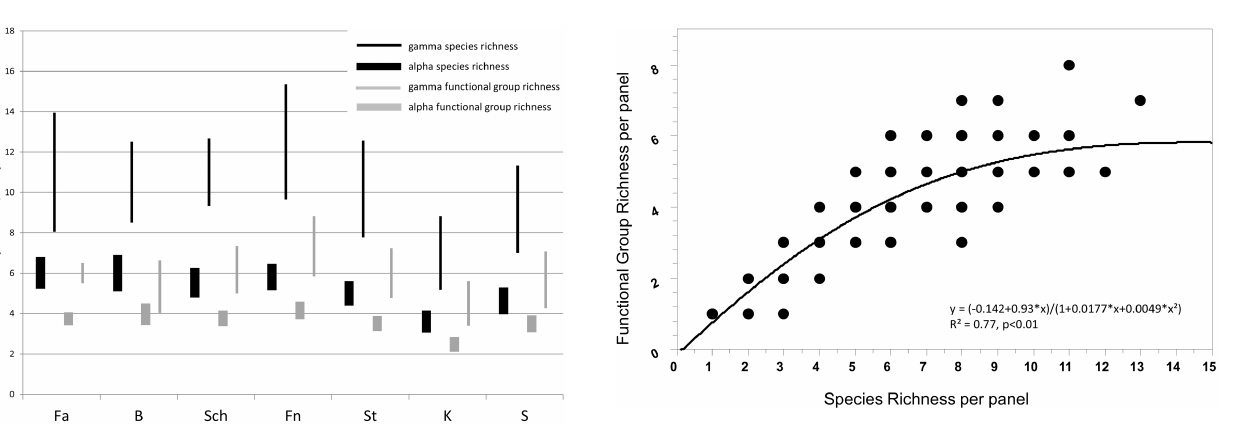
Fig. 4. Confidence intervals of richness in species and in func- tional groups at the panel (alpha diversity) and station level (gamma diversity). Here and elsewhere: B, Boknis Eck; Fa, Falsh¨oft; Fn, Fehmarn; K, Kellenhusen; S, Salzhaff; Sch, Sch¨onberg; St, Staber- huk.